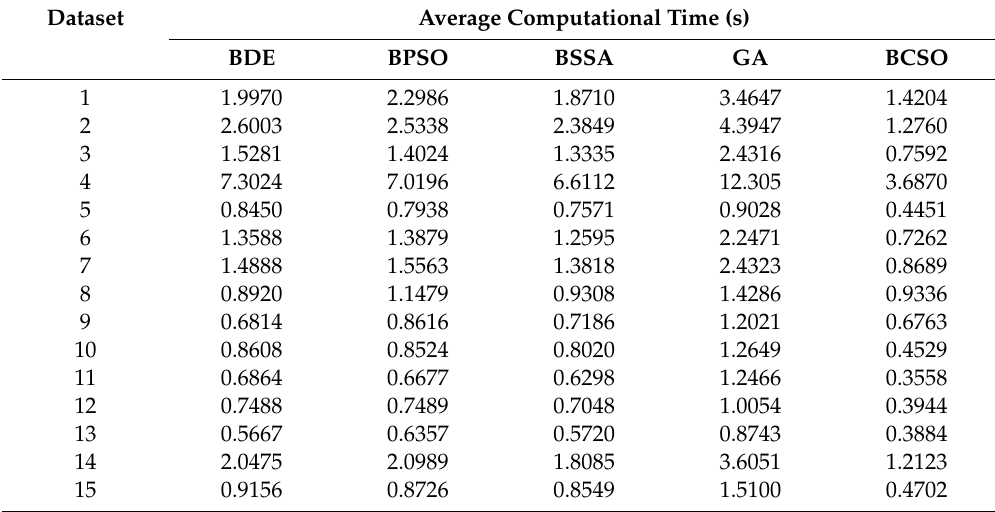
Table 6. Computational cost of BDE, BPSO, GA, BSSA and BCSO on 15 datasets.